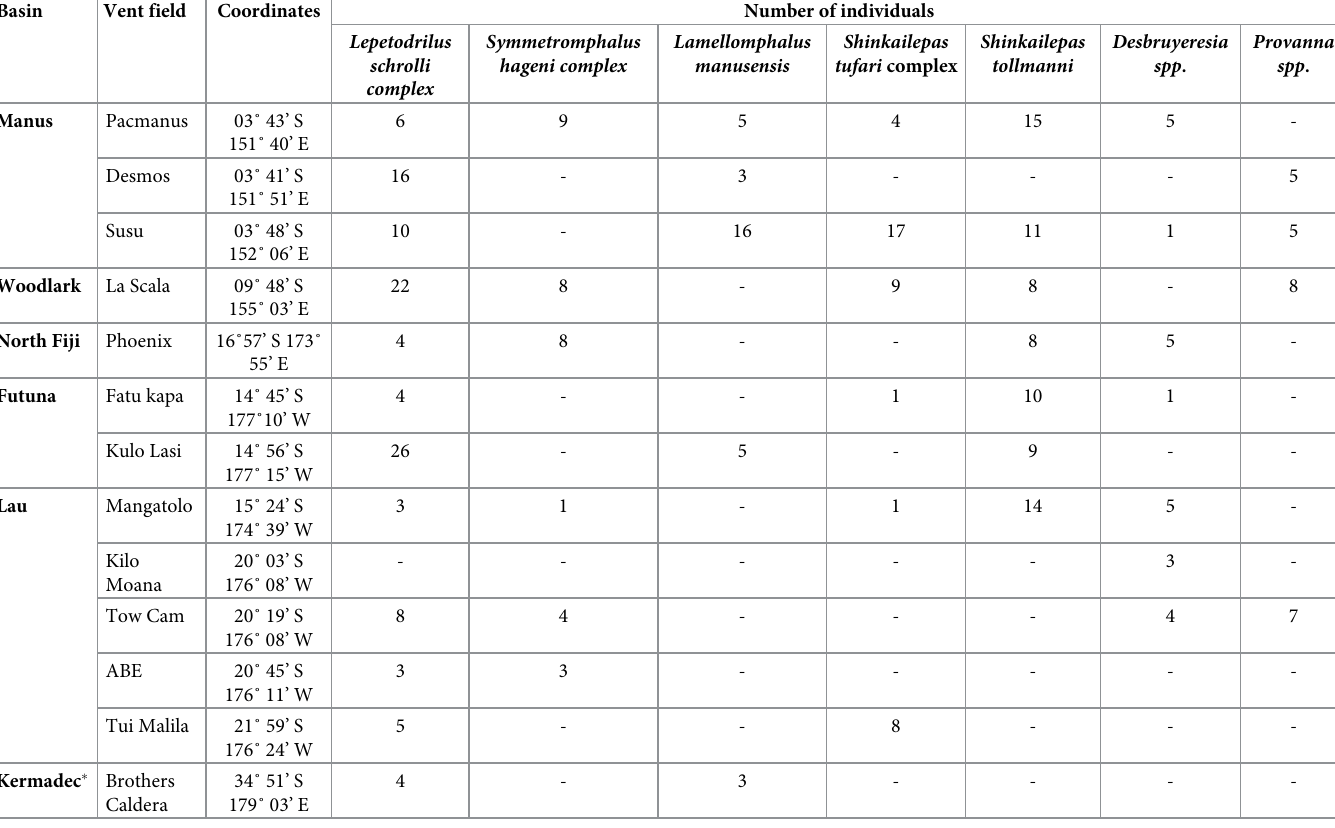
Table 1. Location of gastropods sampled along the South West Pacific back-arc basins and number of individuals used for DNA barcoding. Basin